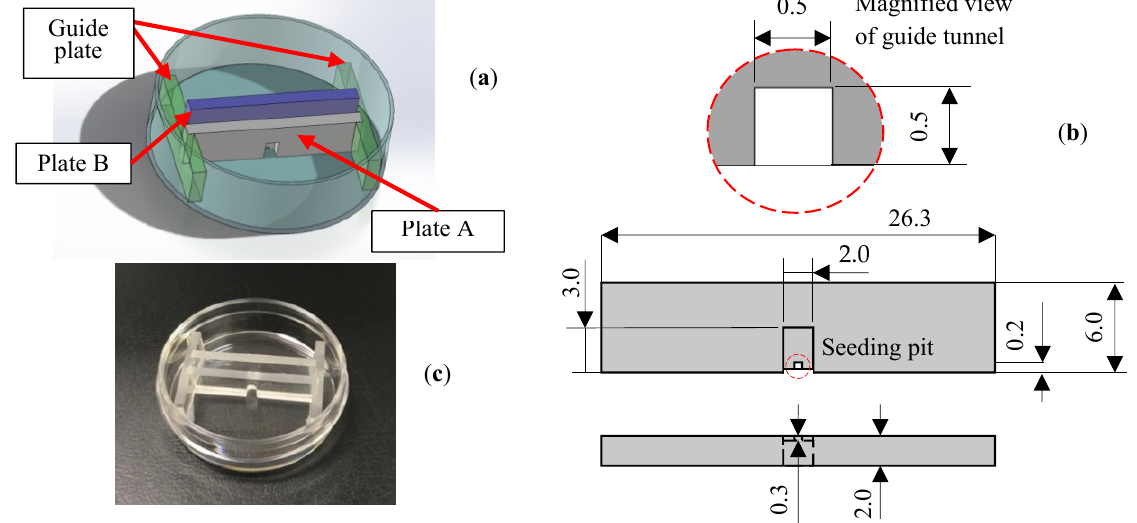
Figure 3. In vitro seeding-damage-reconstruction device. Retractable twin plates (A, B) built in culture dish to be used for the reconstruction experiments of the damaged neuronal cell colony. ( a ) Construction schematic of the system. ( b ) Details of plate A and its 2.0 × 3.0 × 1.7 mm seeding pit and 0.5 × 0.5 × 0.3 mm guide tunnel. ( c ) Real view of the developed system built in the φ 35 culture dish.